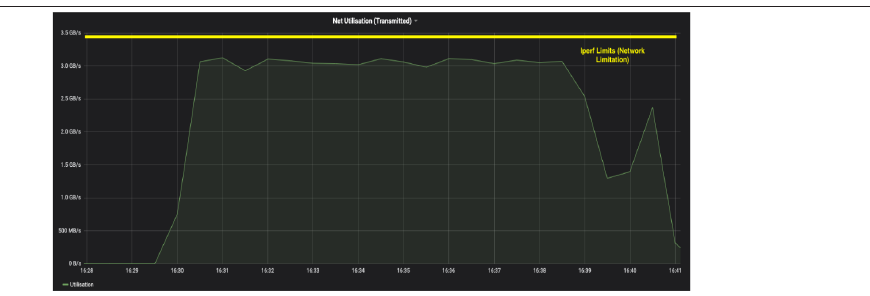
Figure 3. Best achieved network performance on XRootD HTTP TPC tests. The yellow line represents the achieved limit running Iperf3 between same pods.